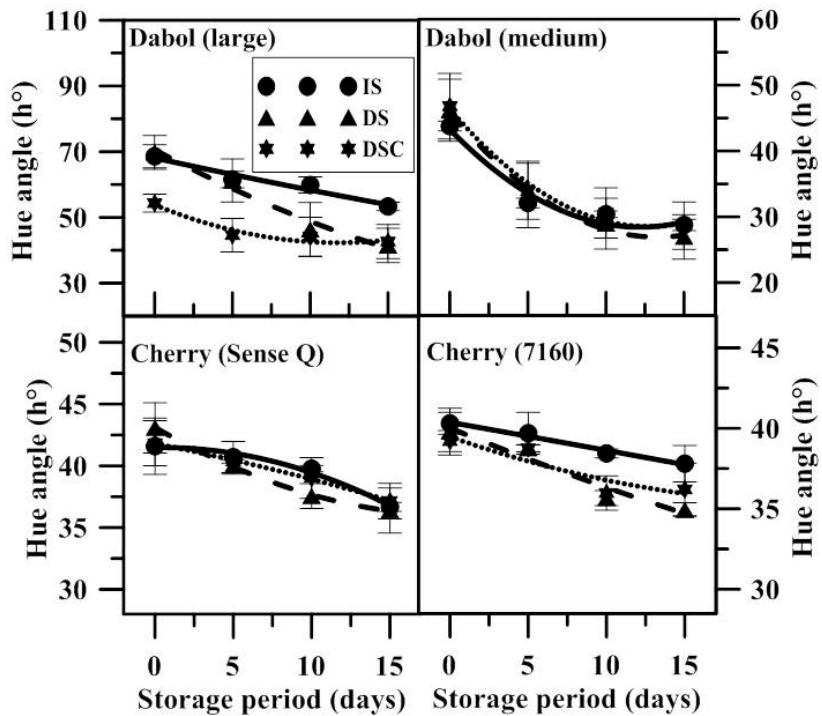
Figure 5. Changes in hue angle ( h ◦ ) of four tomato cultivars over 15 days of storage under IS (immediate storage), DS (storage delayed 24 h), and DSC (storage delayed 24 h under cover) postharvest treatments.